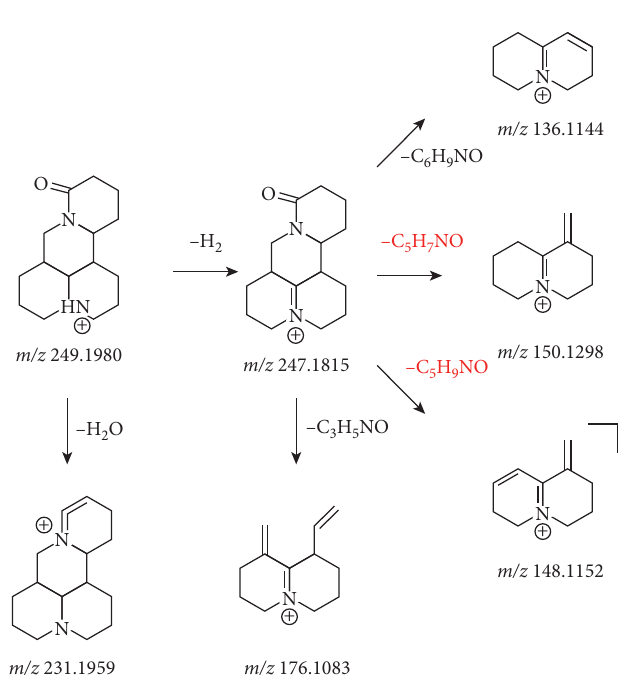
Figure 3: The fragmentation process of matrine in the positive ion